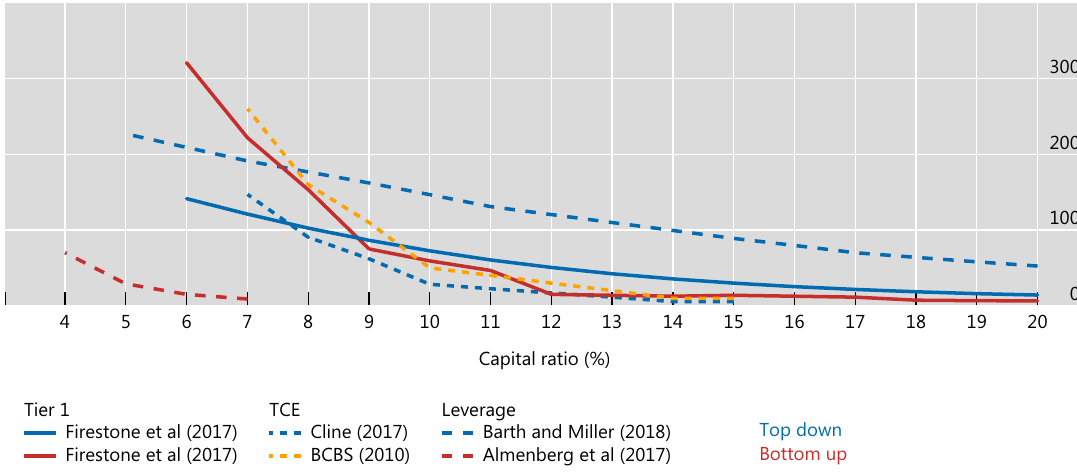
Figure 7. Reduction in crisis probability (bps).